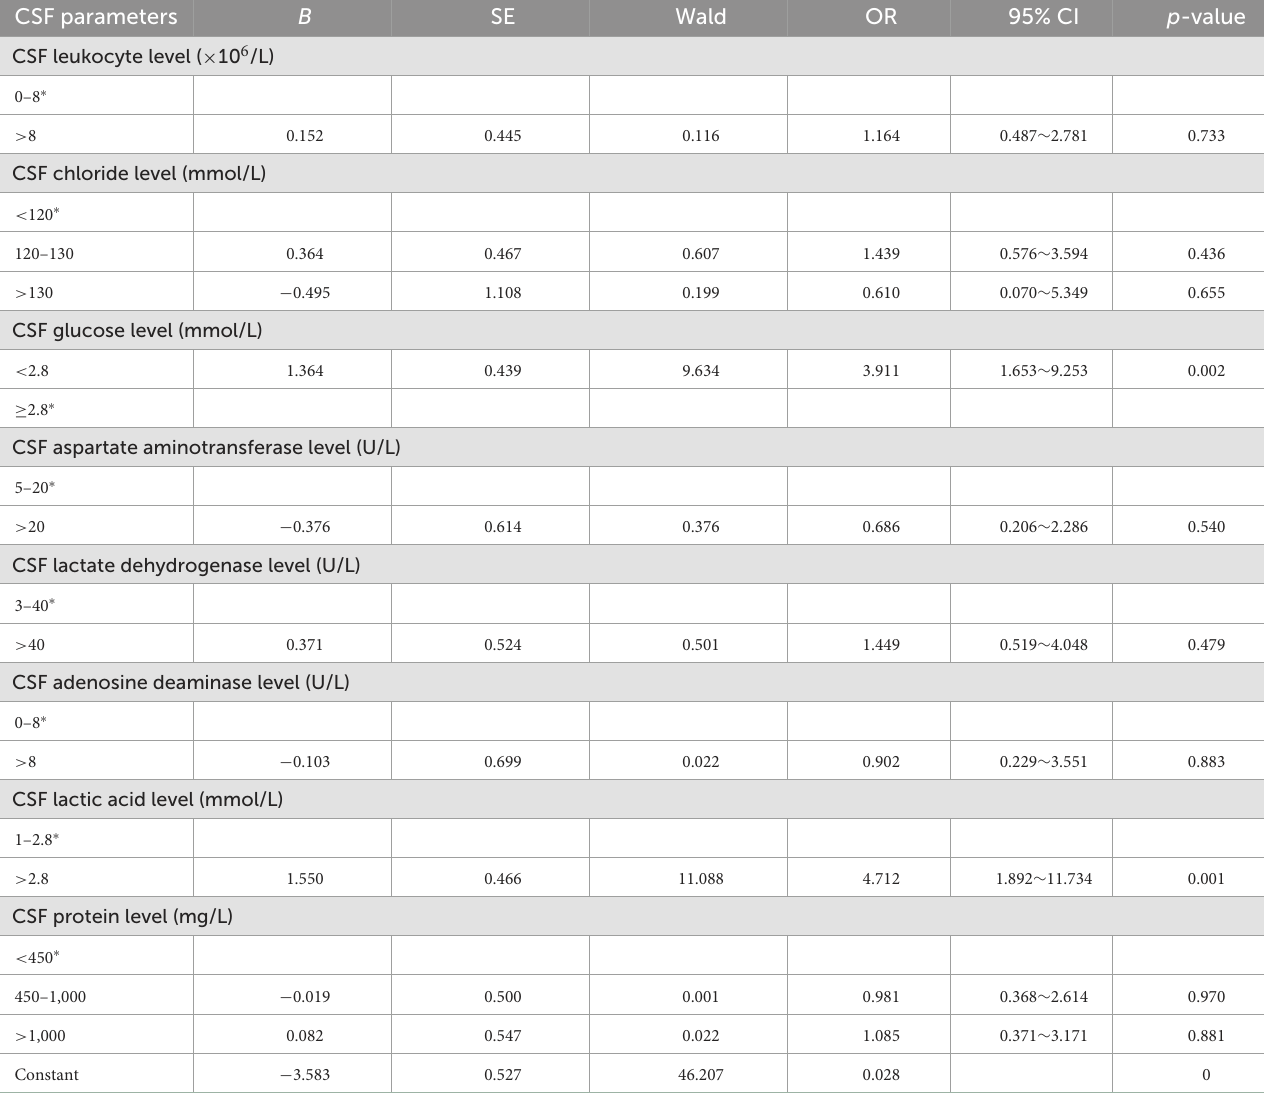
TABLE 4 Multifactor analysis of postoperative infection caused by cerebrospinal fluid parameters before ventriculoperitoneal